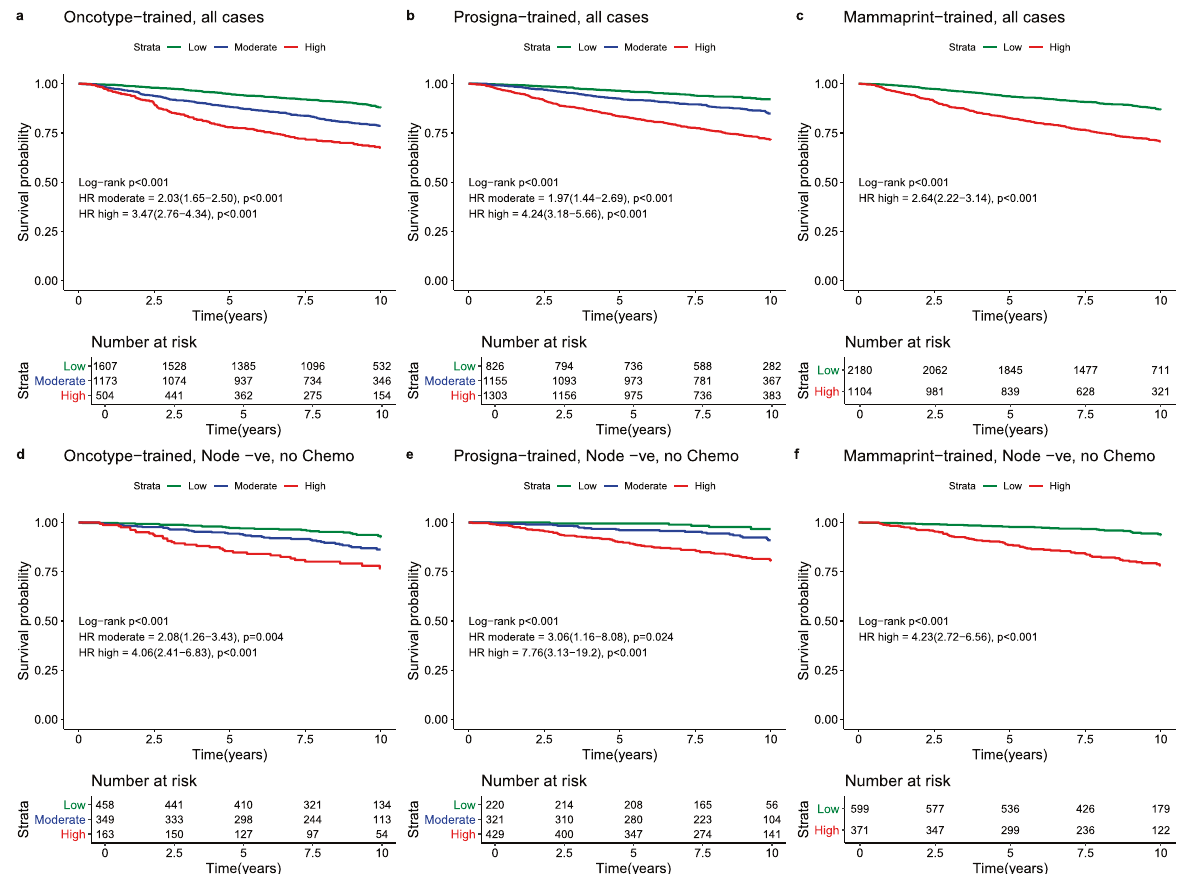
Fig. 1 Test performance in ER + ve, HER2-ve breast cancer from the TEAM cohort. Kaplan – Meier survival curves with Log-rank Hazard ratios for cases of ER + ve, HER2 − ve breast cancer from the entire TEAM cohort for Oncotype-trained (Panel a ), Prosigna-trained (Panel b ), and Mammaprint-trained results (Panel c ) and for ER + ve, HER2 − ve Node negative breast cancers treated without chemotherapy from the TEAM cohort for Oncotype-trained (Panel d ), Prosigna-trained (Panel e ), and Mammaprint-trained results (Panel 5). Log-Rank P values for each test are in brackets. Within each panel low (green), moderate (blue) and high (red) risk survival curves are plotted with LogRank Hazard ratios for high risk and intermediate risk (Oncotype-trained and Prosigna-trained only) calculated against low risk cases in each sub-group. 95% Con fi dence intervals for LogRank Hazard ratios are in brackets. For each group the number at risk (Low, moderate, high) are presented under the X